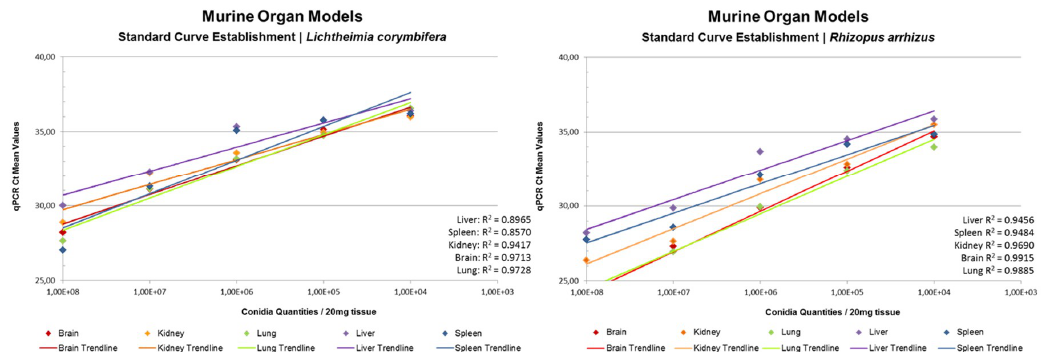
Figure 6. Standard curve obtained for murine organ models of conidia-spiked brain, kidney, lung, liver, and spleen. Values are given per 20 mg tissue. ( A ) Standard curves for L. corymbifera . ( B ) Standard curves for R. arrhizus . Standard deviations are given in Table S5.